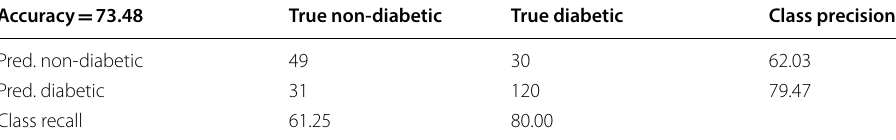
ROC Curve: Results of ROC in shown in Fig. 9—area under curve for the five clas- sification techniques.